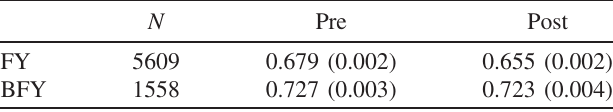
of items answered favorably on both the pre- and post-tests for students in FY and BFY courses for the questions targeting students personal views when doing experiments for